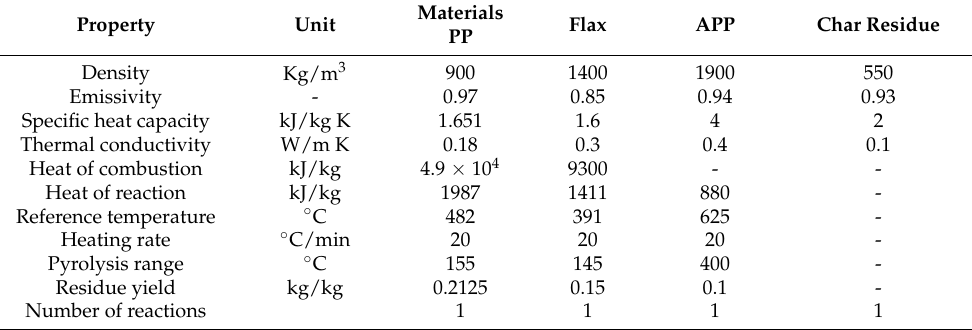
Table 4. The input parameters for the numerical model [46–48].